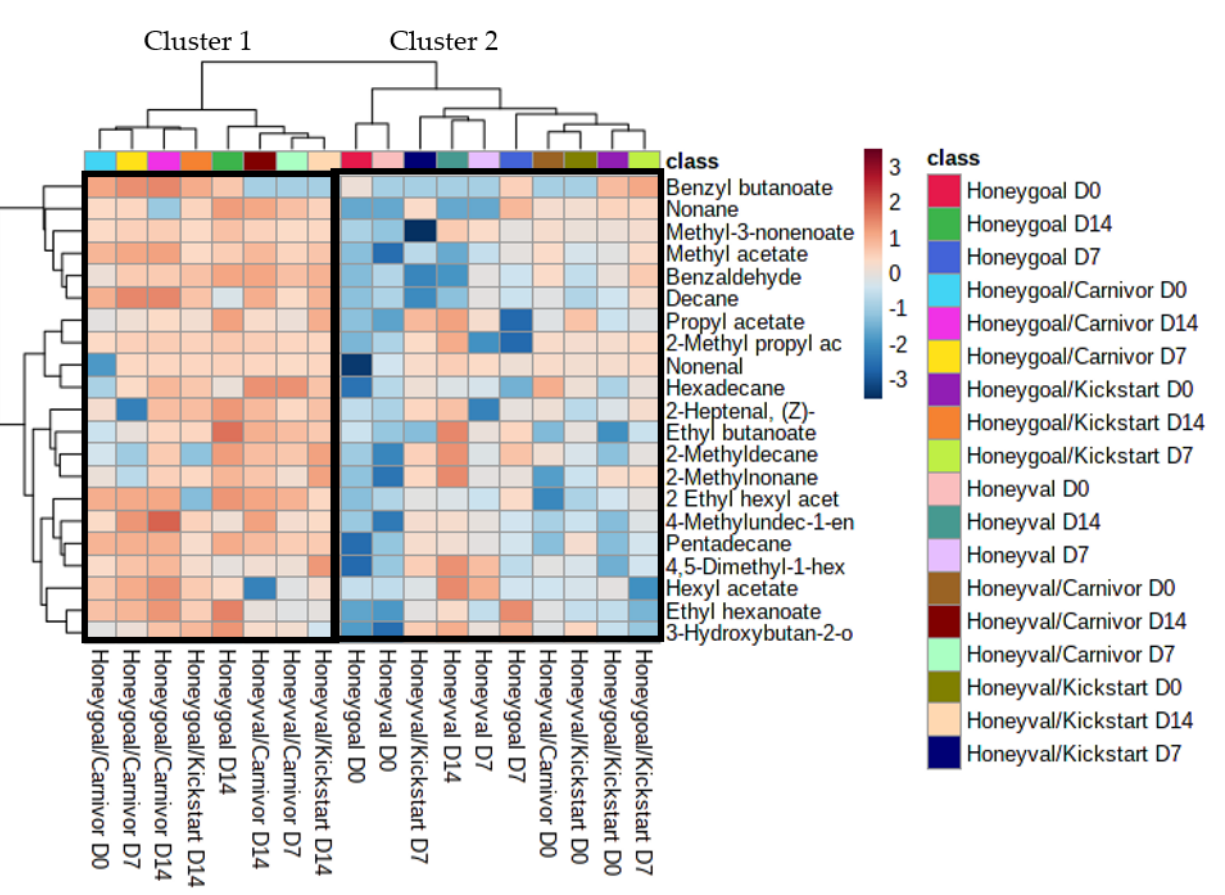
Figure 2. Heat map pattern of volatiles from grafted and un-grafted honeydew melons after postharvest storage.